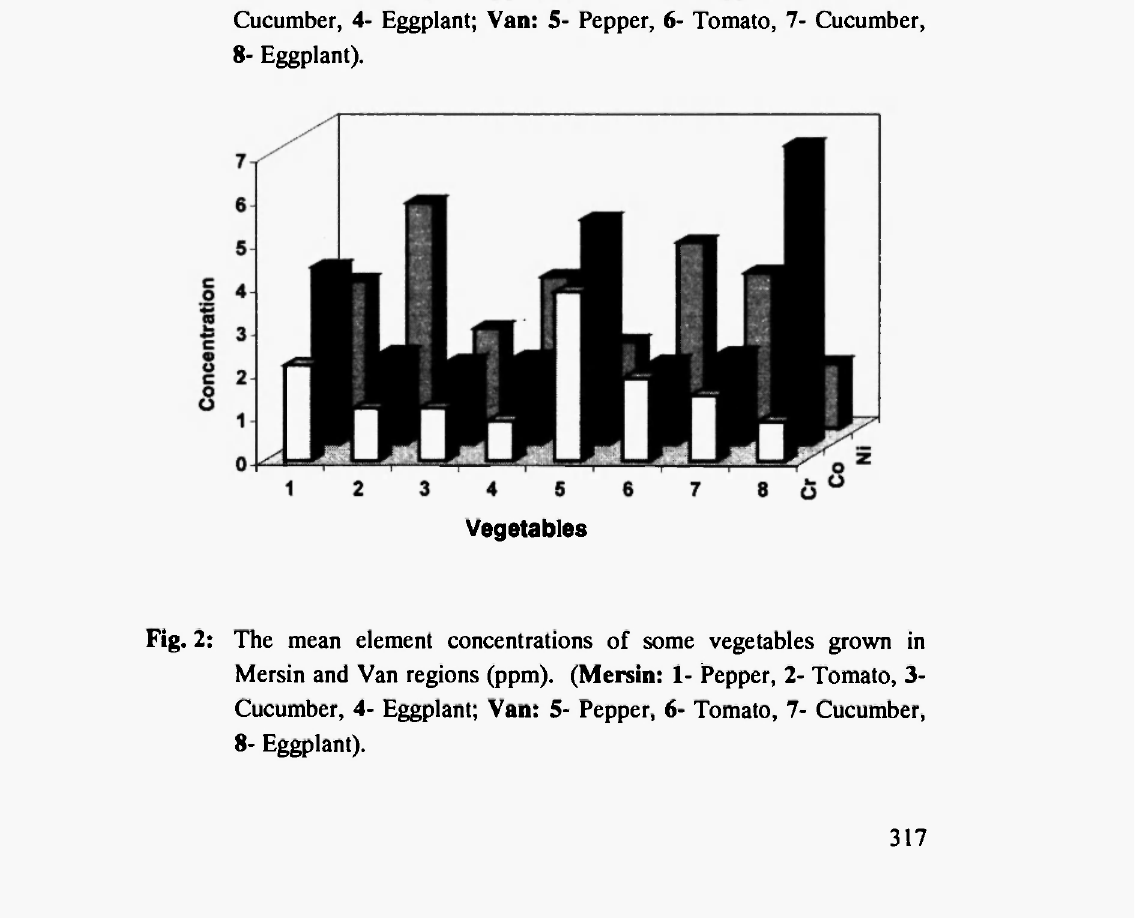
Fig. 1: The mean element concentrations of some vegetables grown in Mersin and Van regions (ppm). (Mersin: 1- Pepper, 2- Tomato, 3- Cucumber, 4- Eggplant; Van: 5- Pepper, 6- Tomato, 7- Cucumber, 8- Eggplant).